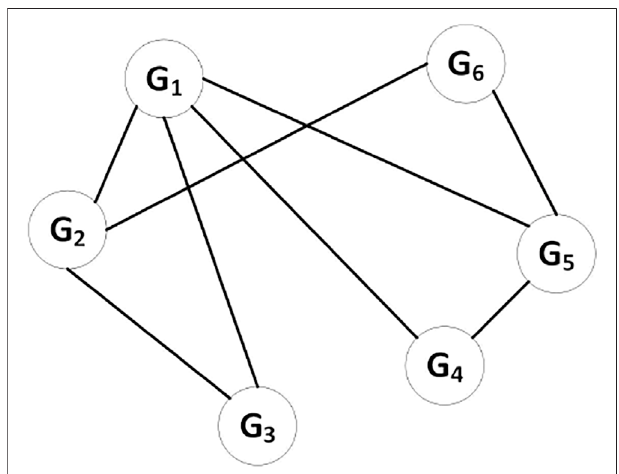
FIGURE 2 | Six generators connected in IEEE-30 bus